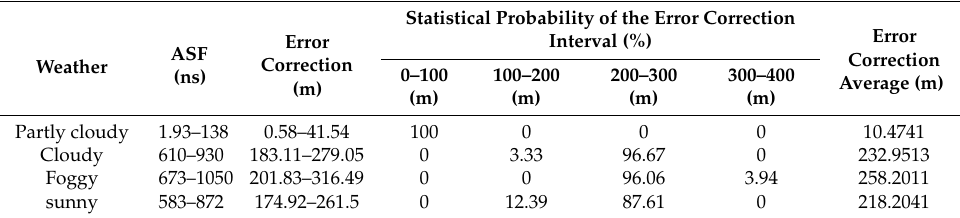
Table 4. The corresponding data change table of Figure